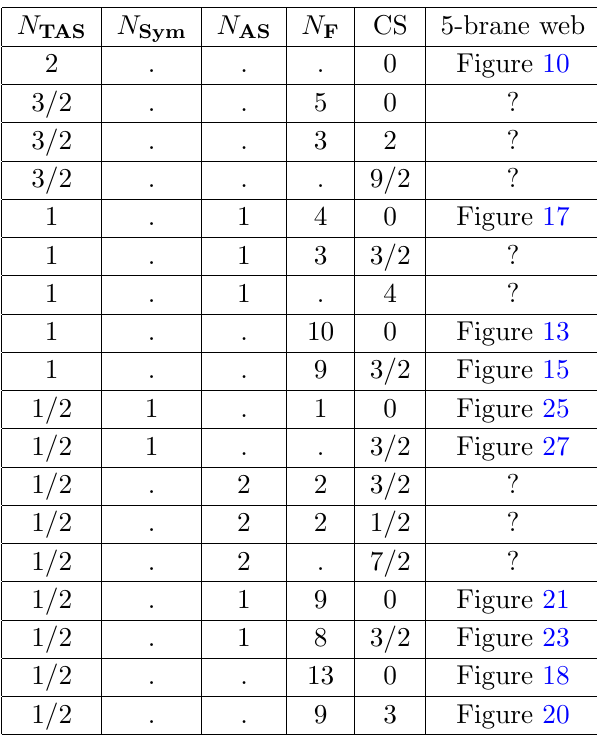
Table 1 . Table for SU(6) marginal theories with rank-3 antisymmetric matter and other matter. N TAS denotes the number of hypermultiplet in the rank-3 antisymmetric representation, N Sym the number of hypermultiplet in the symmetric representation, N AS the number of hypermultiplet in the antisymmetric representation, N F the number of hypermultiplet in the fundamental representation, and CS the Chern-Simons level.